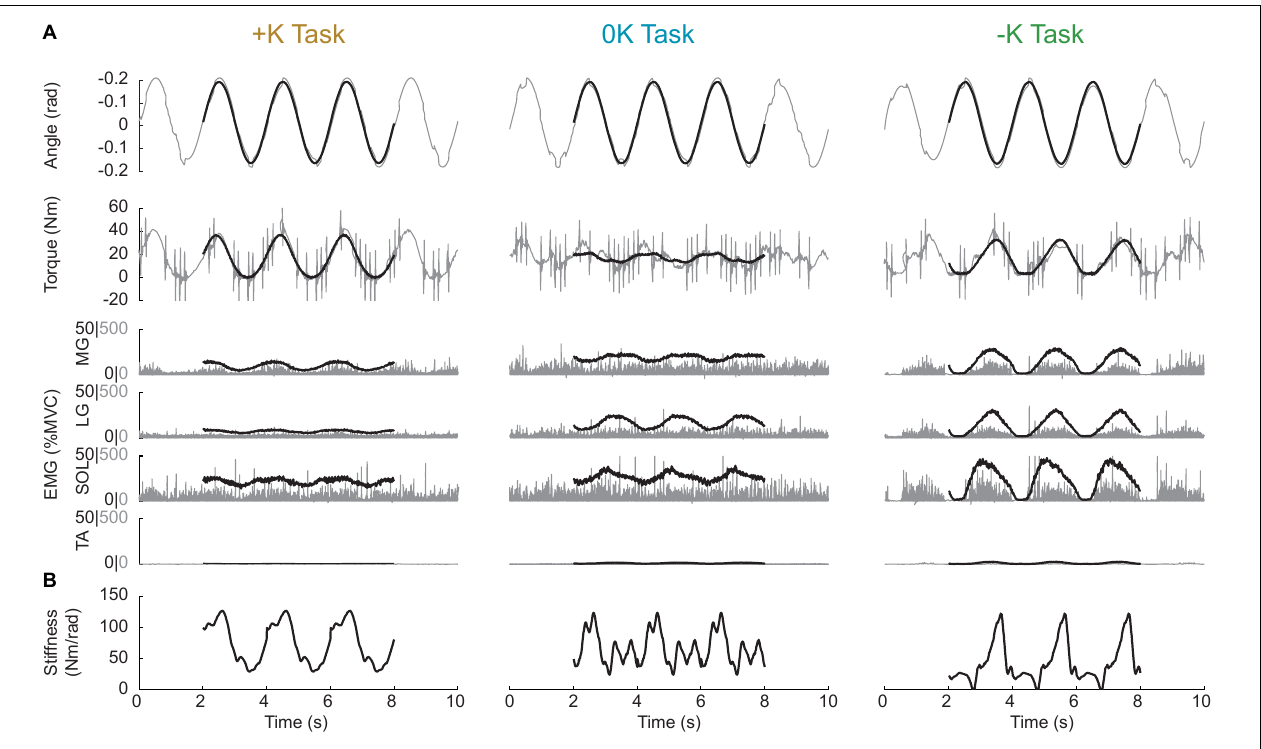
FIGURE 4 | Sample data from a representative subject. (A) 10-s snippet of raw data (gray) along with the average of the best 200 segments gathered from the data (black line) for all three tasks. (B) Estimates of the stiffness component of impedance throughout the task. Impedance, and hence stiffness, could only be computed with the ensemble of the 200 segments, thus we do not have estimates for a single trial, to match the 10-s snippets shown in (A)